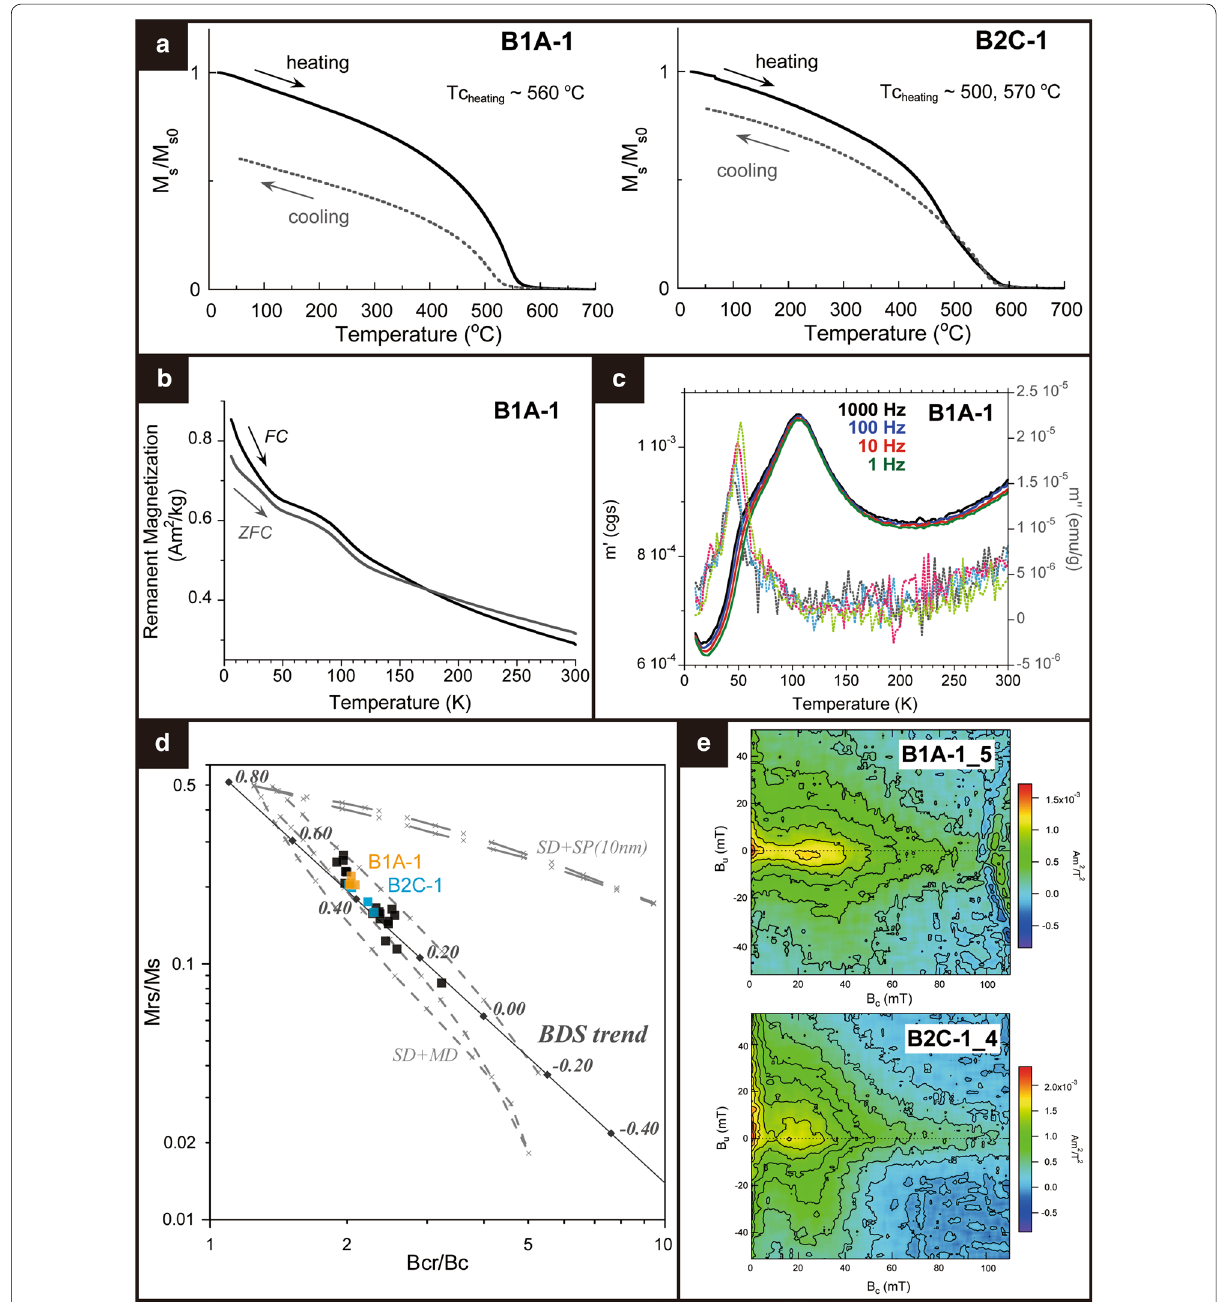
Fig. 2 Summary of rock magnetic results. a High‑temperature strong‑field thermomagnetic curves between the room temperature and 700 °C on two subsamples (B1A‑1 and B2C‑1). Solid (dotted) line shows heating (cooling) curve. b Low‑temperature heating curves of ZFC and FC remanences from 10 to 300 K on a subsample B1A‑1. c Low‑temperature low‑field thermomagnetic curves (only heating curves) of the in‑phase magnetic susceptibility (m ′ ) and the out‑of‑phase susceptibility (m ″ ) with different frequencies on a subsample B1A‑1. d Mrs/Ms versus Bcr/Bc diagram for the studied samples (square symbols) yielding an acceptable Tsunakawa–Shaw API estimate (see Table 2), with the theoretical curves for mixtures of SD and MD particles (three dashed lines), for the mixtures of SD and SP (10 nm in size) particles (two long‑dashed lines) by Dunlop (2002a, b), and the BDS trend line (solid line) with labels of some BDS values (diamond symbols) by Paterson et al. (2017). e FORC diagrams for two subsamples B1A‑1_5 and B2C‑1_4 with a smoothing factor =